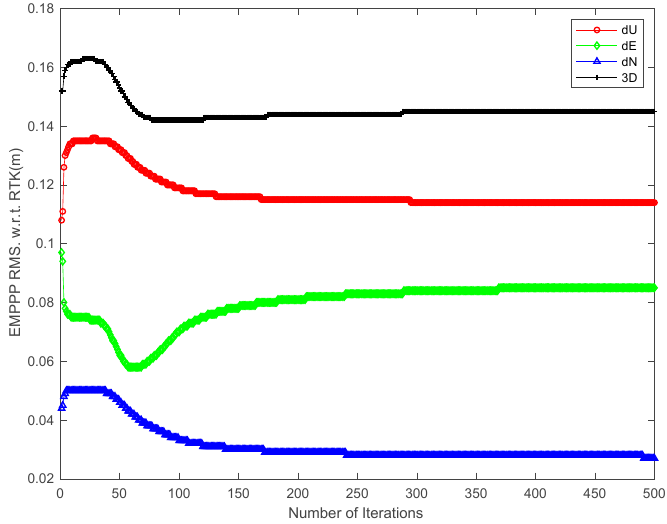
Figure 10. EM-PPP RMSs w.r.t. RTK solution in Up, East and North (unit: m).